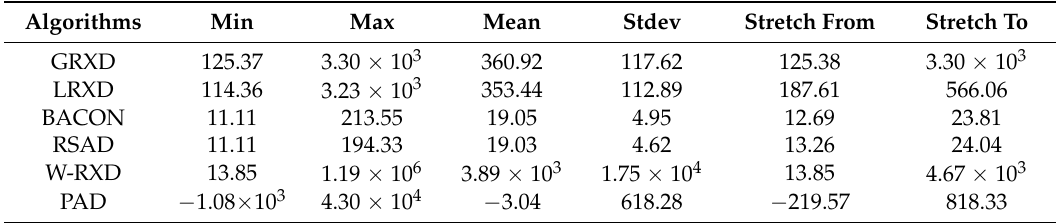
Table 3. The statistic and stretching information of the six grayscale images for the SpecTIR data set.